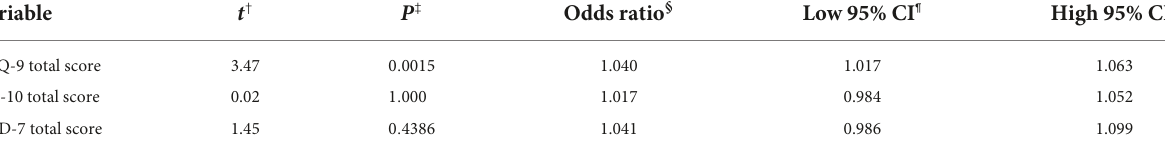
TABLE 6 The results of the three ordinal logistic regressions of GCPS on the total scores of PHQ-9, PSS-10, and GAD-7.